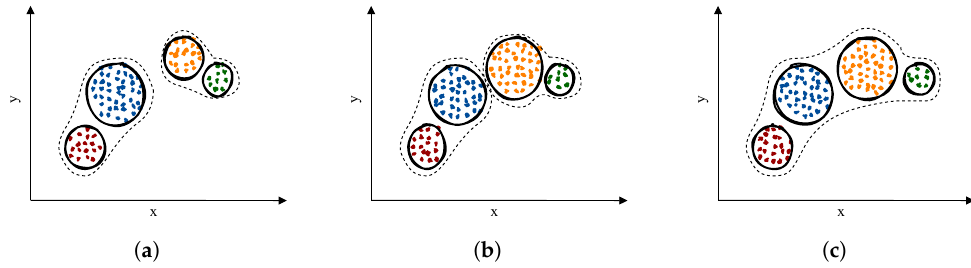
Figure 4. Merging process in Macro SOStream. ( a ) Two arbitrary-shaped macroclusters. ( b ) The two macroclusters approached with the arrival of new samples. ( c ) A macrocluster as a result of merging the two old macroclusters represented in ( b